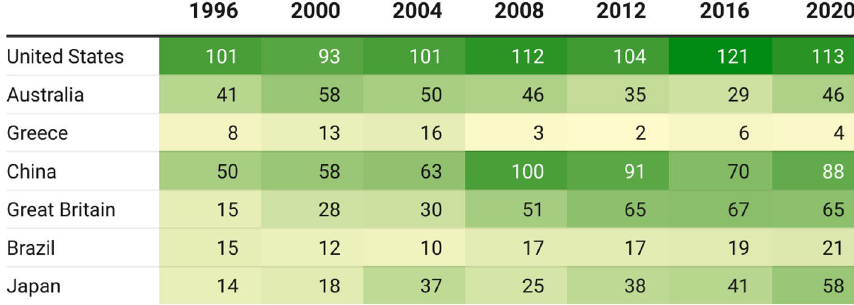
Figure 1. Medal count of host countries: Summer Olympic